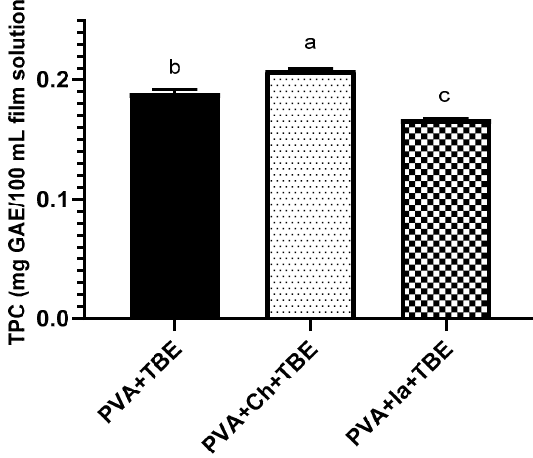
Figure 4. Total phenolic content (Folin–Ciocalteu method).